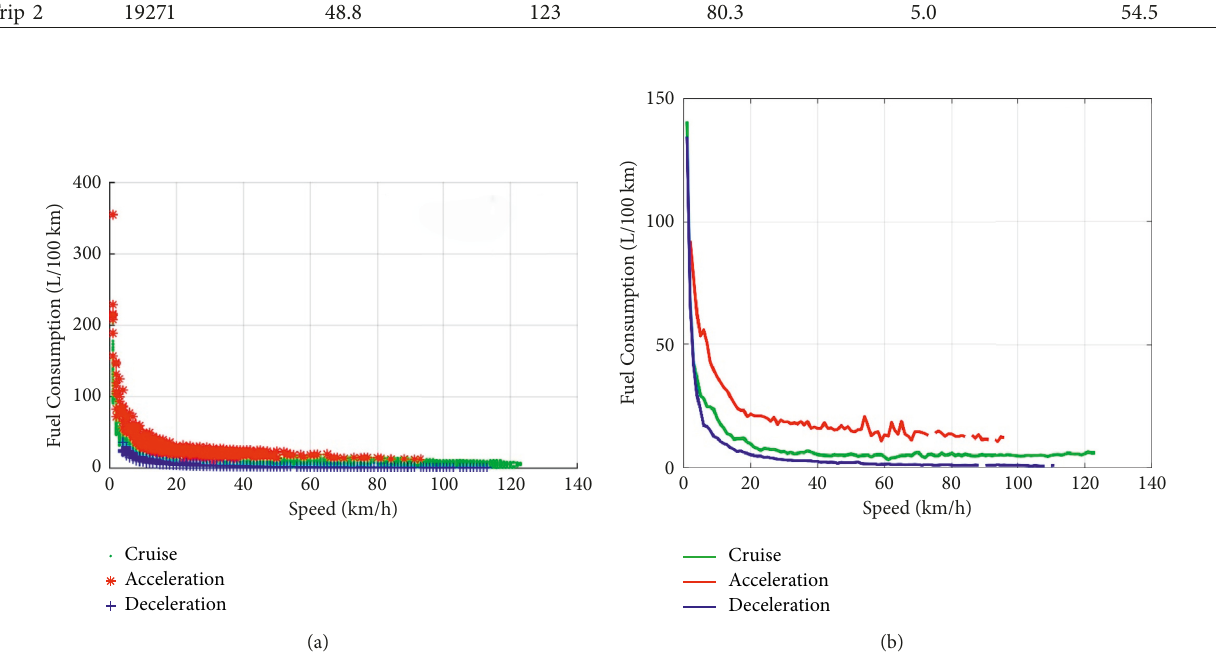
Figure 5: Relationship between speed and fuel consumption.